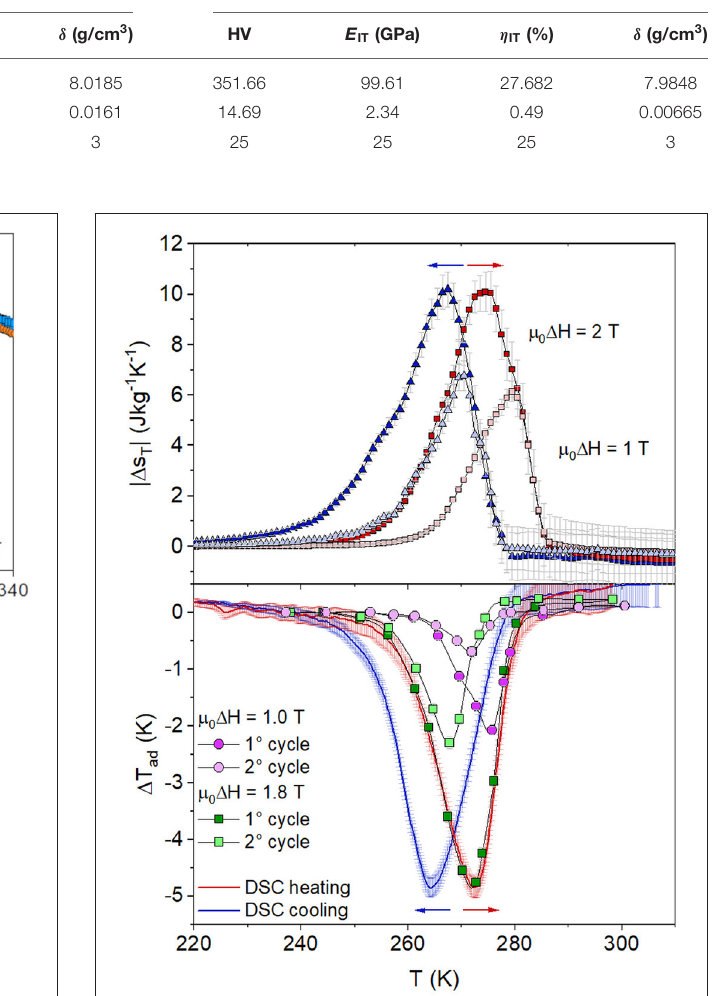
FIGURE 5 | Top panel : 1 s T ( T ) of the B250 sample for a magnetic field change of 2.0T (filled symbols) and 1.0T (empty symbols) on heating (red squares) and on cooling (blue triangles). Bottom panel : 1 T ad ( T ) of the B250 induced by applying in the first and second cycles a magnetic field of 1.0T (circles) and 1.8T (squares) and derived from in-field differential scanning calorimeter (DSC) measurements (red and blue lines) for a µ 0 1 H of